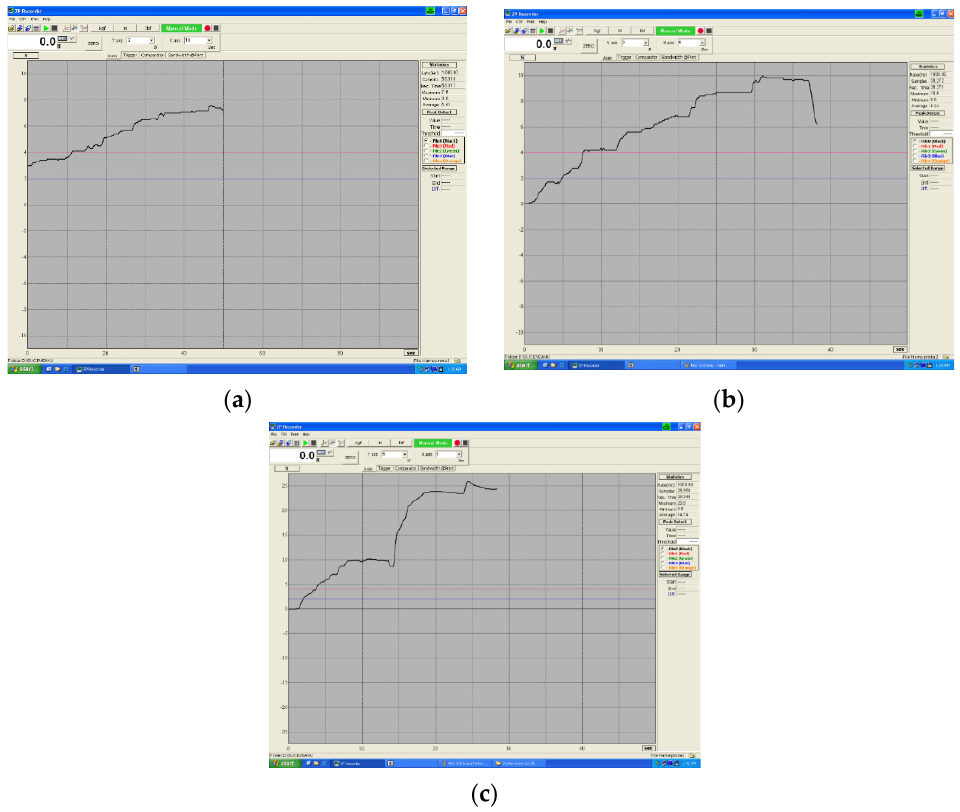
Figure 8. ( a – c ) Evolution of Cr-Co spring deformations (time-force). For the 0.9 mm Ni-Cr wire, the results are listed in Table 3. Table 3. Results for Ni-Cr 0.9 mm